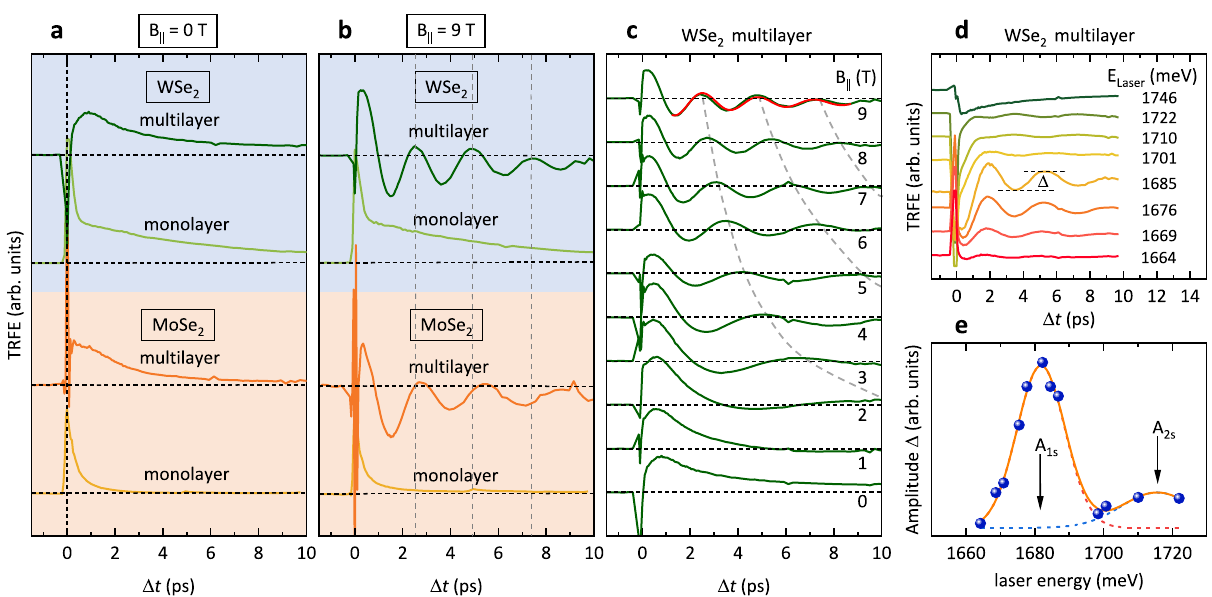
Fig.2|TRFEexperimentsinin-planemagnetic fi elds. ComparisonofTRFEtraces of allsamples at a B ∥ =0, and, b B ∥ =9 T,excitedatthe A 1s excitonicresonances. In themultilayersamples,strongtemporaloscillationsareobservedinthetimetraces at B ∥ =9T,incontrasttothemonolayersamples,whichshownooscillations. c TRFE traces of the WSe 2 multilayer for different in-plane magnetic fi elds. The red solid line represents an exponentially-damped cosine fi t to the data. The dashed gray linesareguidestotheeye. d TRFEmeasurementsoftheWSe 2 multilayerat fi xedin-